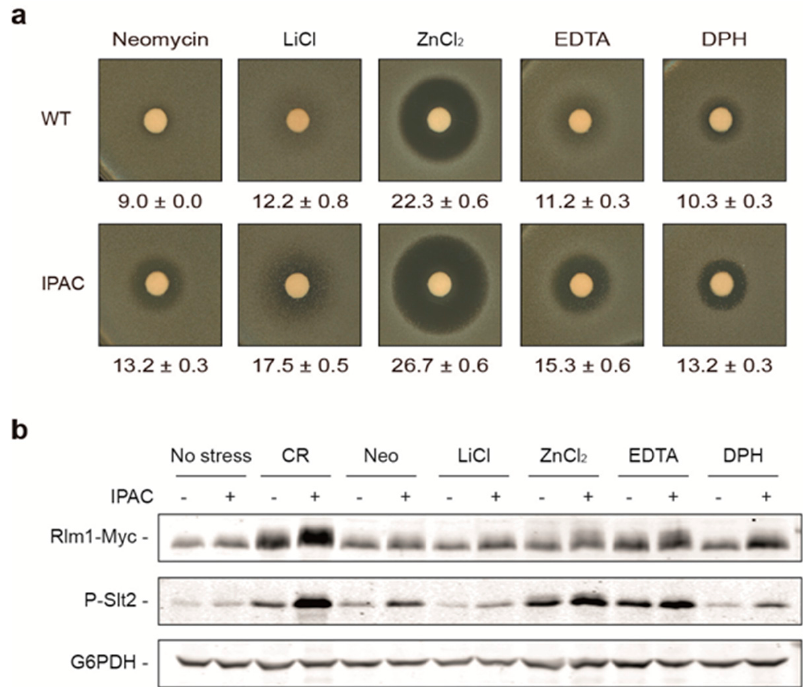
Figure 2. Neomycin, lithium chloride (LiCl), zinc chloride (ZnCl2), ethylenediaminetetraacetic acid (EDTA), and diphenhydramine chlorhydrate (DPH) activate the IPAC circuit. ( a ) Growth inhibition halo assay of vector (WT) or IPAC-integrated Y3656 strains. Six-millimeter-diameter disks were impregnated with 50 mg/mL neomycin sulfate, 424 mg/mL LiCl, 136 mg/mL ZnCl 2 , 11 mg/mL EDTA, or 50 mg/mL DPH. Mean and standard deviations of halo diameters from three different experiments are shown. ( b ) Western blotting analysis of extracts from BY4741 RLM1- 6MYC strain transformed with YCplac111 ( − ) or Ycplac111-IPAC (+) and treated or not (no stress) for 3 h with 30 µ g/mL CR, 10 mg/mL neomycin (Neo), 8.5 mg/mL LiCl, 681.4 µ g/mL ZnCl 2 , 11.2 mg/mL EDTA, or 1 mg/mL DPH. Rlm1-Myc, dually phosphorylated Slt2, and G6PDH (as a loading control) were detected with anti-Myc, anti-phospho-p44/42, and anti-G6PDH antibodies, respectively. A representative blot from two independent experiments is